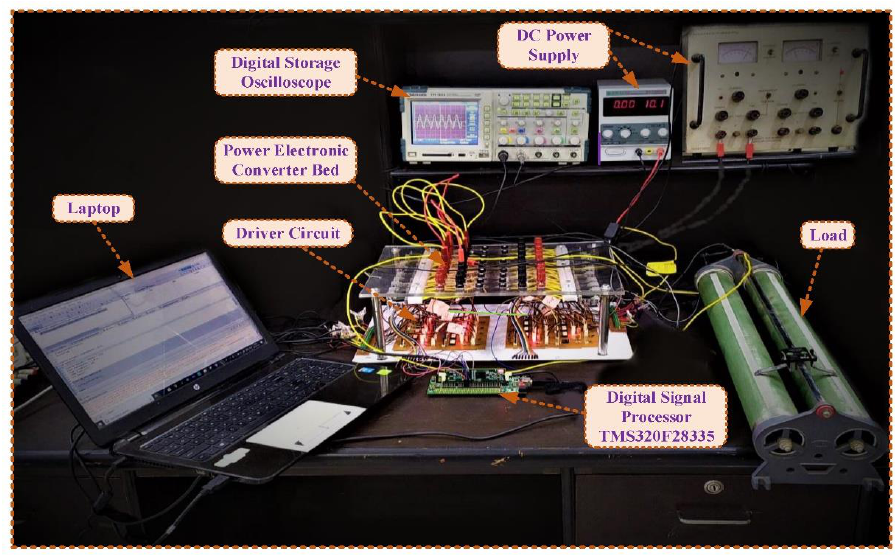
Figure 23. Laboratory Hardware setup.